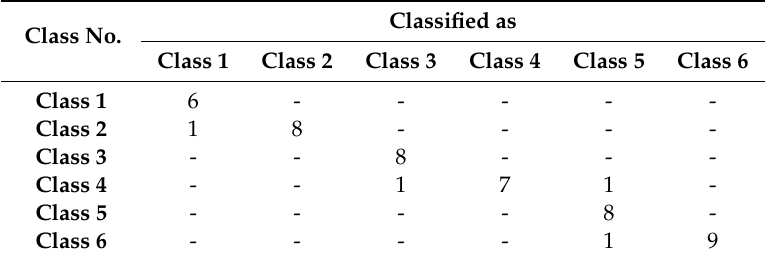
Table 4. Test results of the RUL classification model using feature of PDD (range 3.75–3.5).